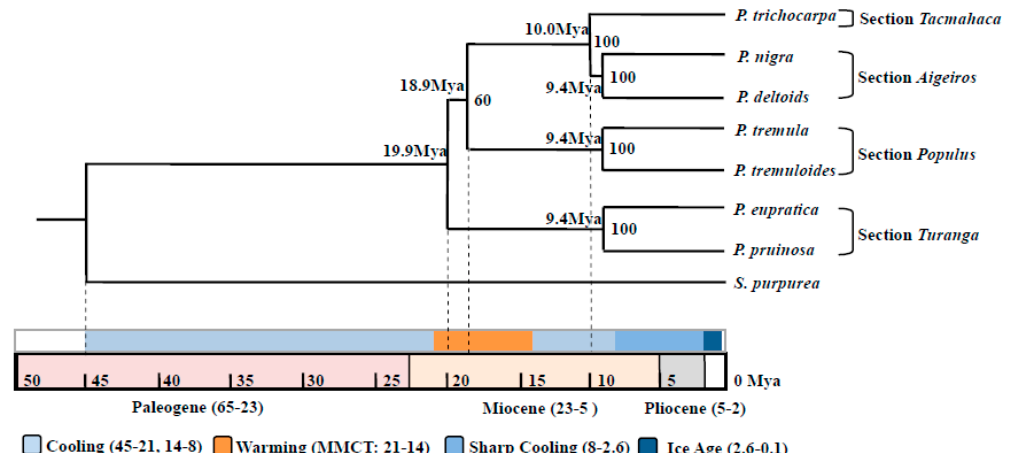
Figure 3. Phylogenetic tree of seven Populus and one Salix species. Phylogram derived from multiple sequence alignments based on the combined 1835 orthologous transcripts using maximum likelihood (ML) method (Sequences in File S1). Paleoclimate change is presented by different colors.